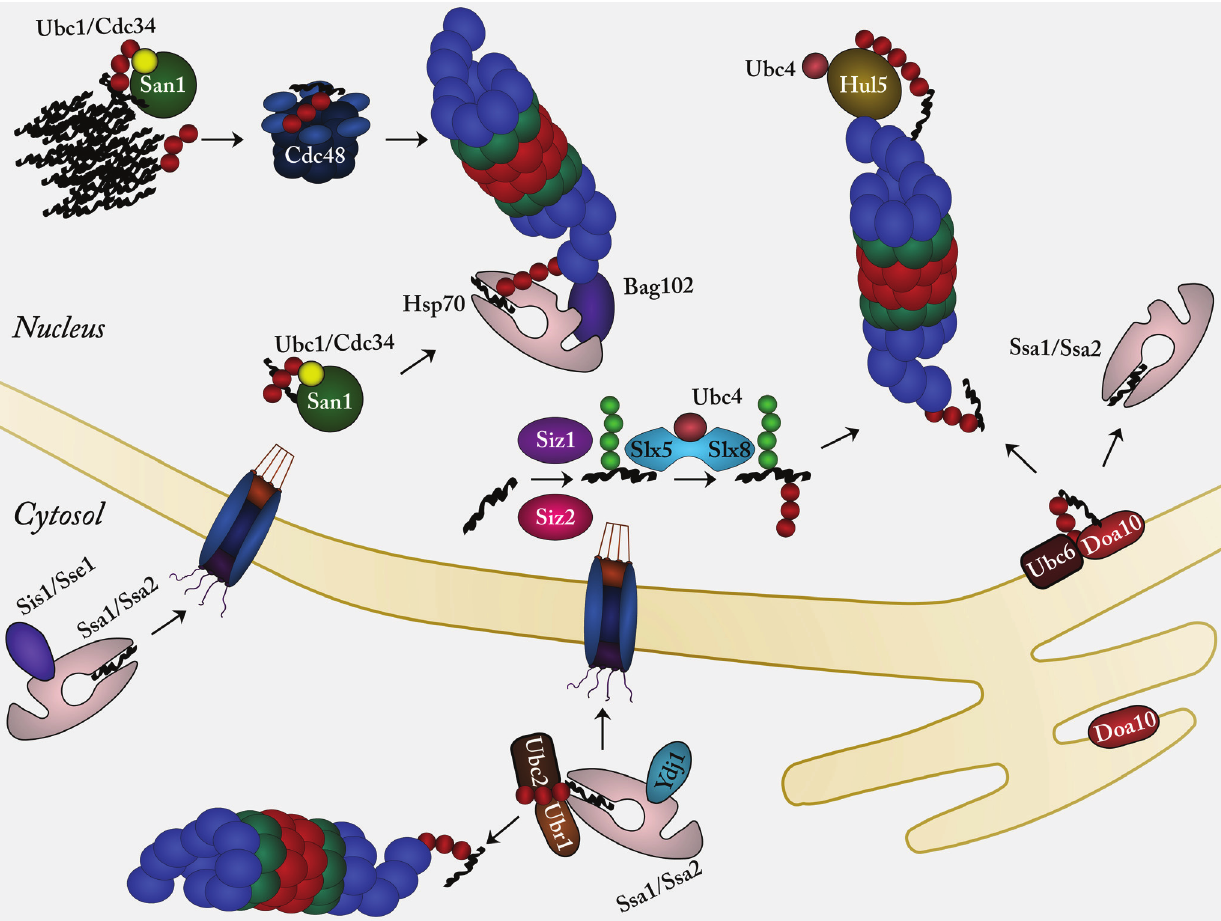
Figure 1. Pathways for nuclear protein quality control in yeast. Conjugating ubiquitin (red sphere) to misfolded proteins (black thread) occurs in the nucleus primarily via the San1 E3 ubiquitin-protein ligase (green sphere) and its cognate E2 enzymes Ubc1 (yellow) and Cdc34 (dark red). In fission yeast the Bag102 Hsp70/proteasome co-factor links Hsp70 chaperones (pink) directly with the 26S proteasome. The transmembrane ER/nuclear envelope E3 ligase Doa10 (red) and its cognate E2 Ubc6 (brown) also target certain Ssa1 and Ssa2 Hsp70 (pink) clients for proteasomal degradation. The Slx5-Slx8 heterodimeric STUbL (blue) targets misfolded proteins that have first been marked with SUMO (green sphere) by the SUMO E3s Siz1 and Siz2. The Sis1 and Sse1 co-chaperones (purple) mediate transport of cytosolic chaperone clients to the nucleus. Due to some substrate overlap between San1 and the cytosolic Ubr1 E3 ubiquitin protein ligase, Ubr1 (light brown) and its cognate E2 Ubc2 (dark brown) may also participate in nuclear protein quality control. Finally, at the 26S proteasome the proteasome-associated E3 Hul5 (yellow), may further ubiquitylate the misfolded substrates, to ensure efficient degradation. See text for further